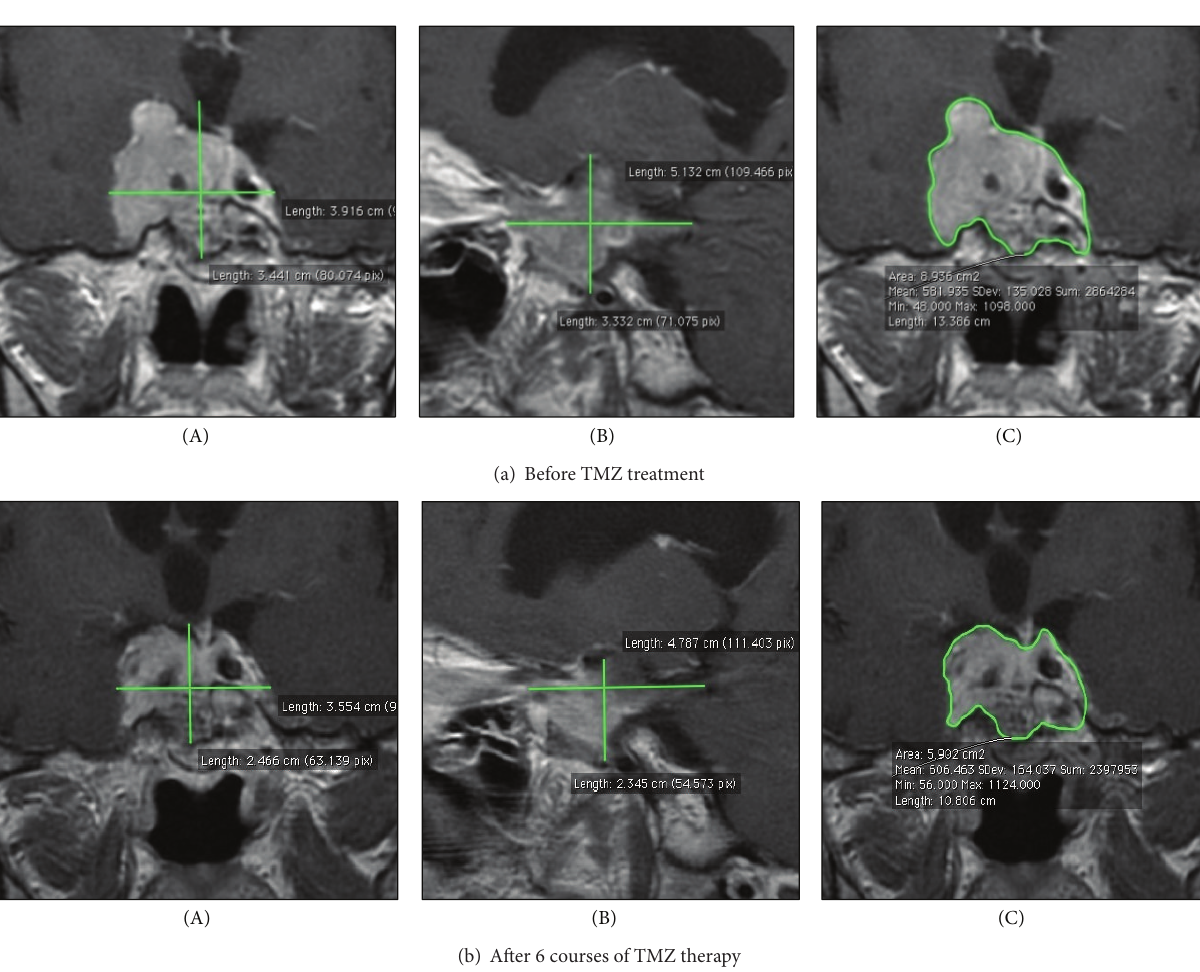
Figure 4: The assessment of tumour size (A, B) based on the MRI picture. The tumour volume (C) was measured using the computer program OsiriX. Frontal (A, C) and sagittal (B)